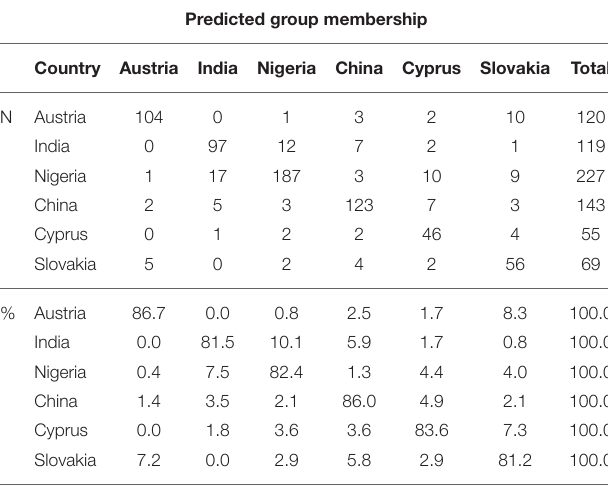
TABLE 10 | Results of classification by discriminant analysis. Predicted group